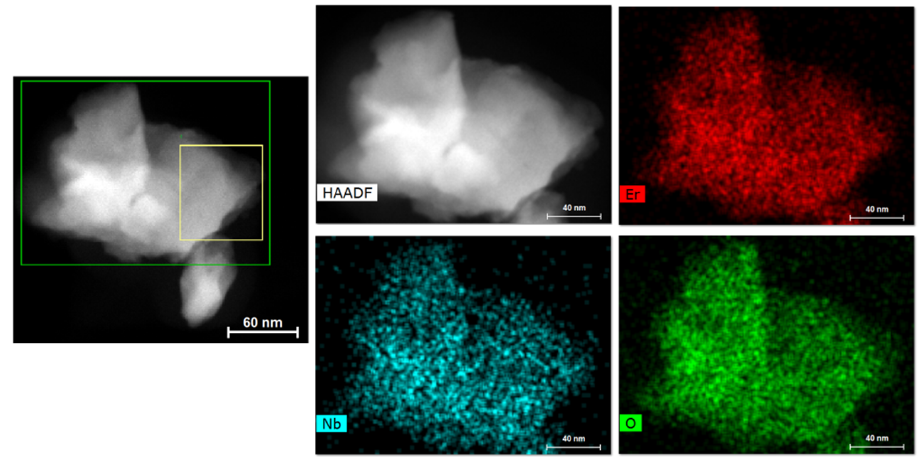
Figure 4. STEM-EDX mapping analysis of the sample HT1600.